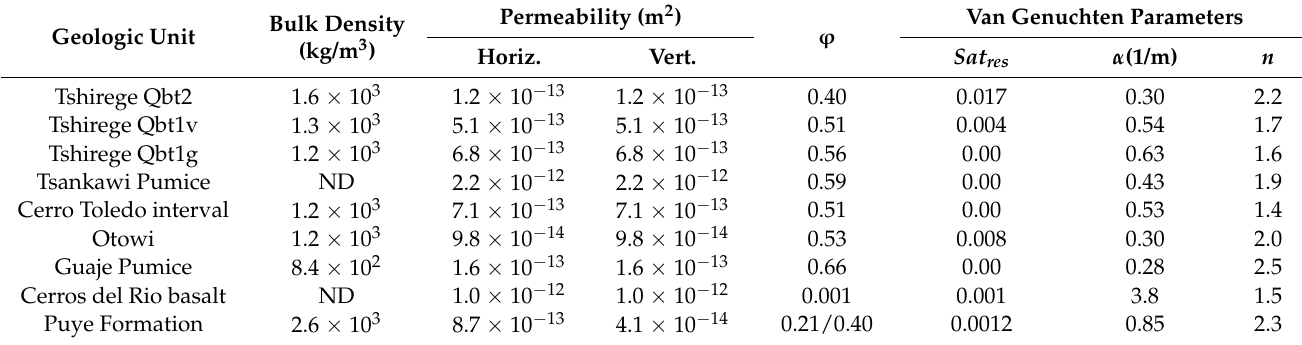
Table 1. Hydrogeologic properties used for the three-dimensional